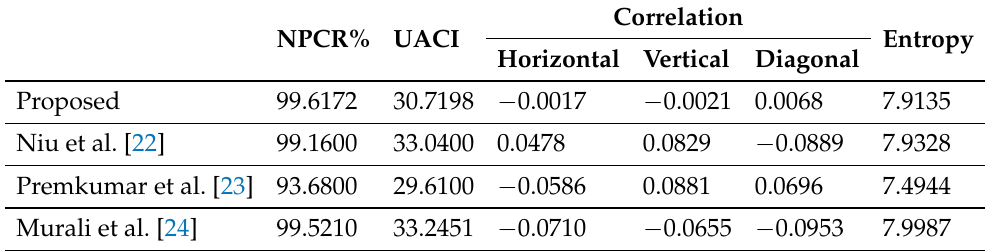
Table 7. Comparison with related